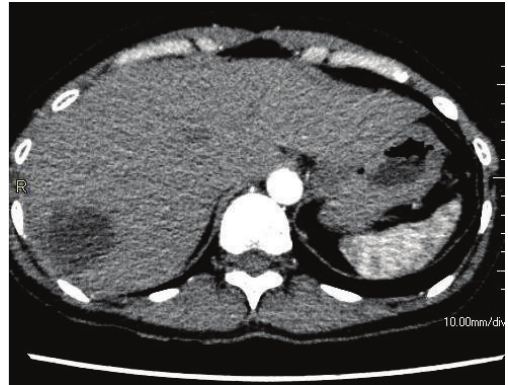
Figure 3: Follow-up CT performed on day 58. The size of the low- density area of the anterior segment of the liver is reduced, and the arterioportal fistula has